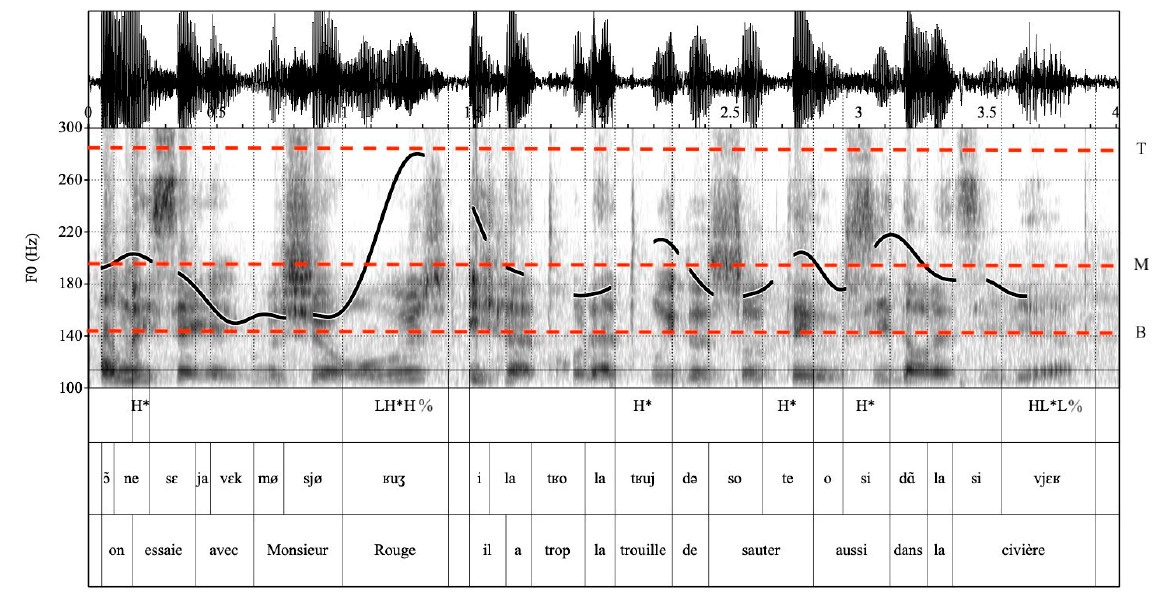
Figure 8. Utterance produced by a French native speaker (25-Sbj01). Accented syllables are indicated with *.